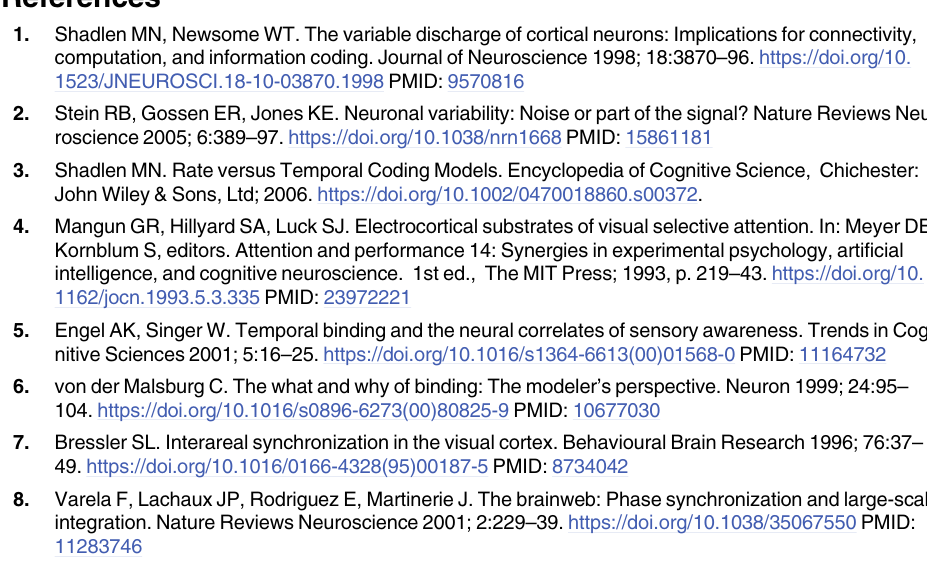
S1 Fig. Suppression of line noise in data does not change the characteristics of the gamma echo in representative magnetometers. Each panel shows the power spectral density (PSD) and TRF for individual participants before (blue line) and after (red line) applying the SSS method to suppress 50 Hz line noise. The echoes remain strong after the 50 Hz line noise is